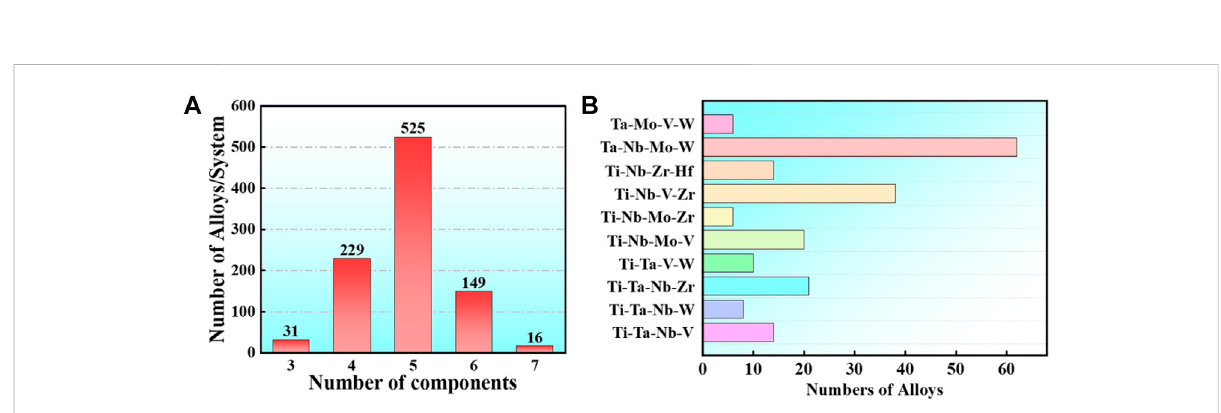
FIGURE 4 In the statistical publications, the frequencies of RHEAs of 3,4,5,6,7 group elements, respectively (A) , while the frequencies of RHEAs based on the most common 4 group element systems of Ta-Nb-Mo-W, Ti-Nb-V-Zr, Ti-Nb-Mo-V, and Ti-Ta-Nb-V are in (B)